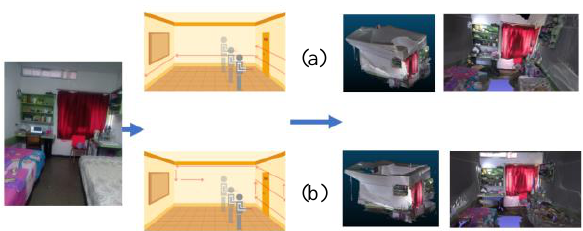
Figure 10. Result of the "level by level" (a) and "wall by wall" (b) scanning.